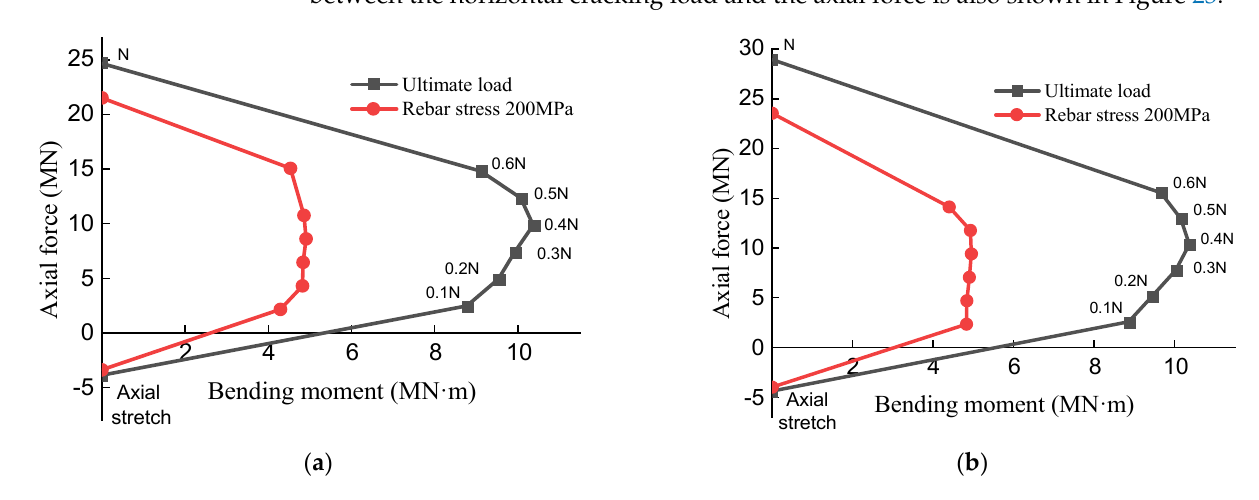
Figure 23. Summary of the M − N diagram. ( a ) Bottom plate thickness is 0.5 m; ( b ) bottom plate thickness is 0.8 m.